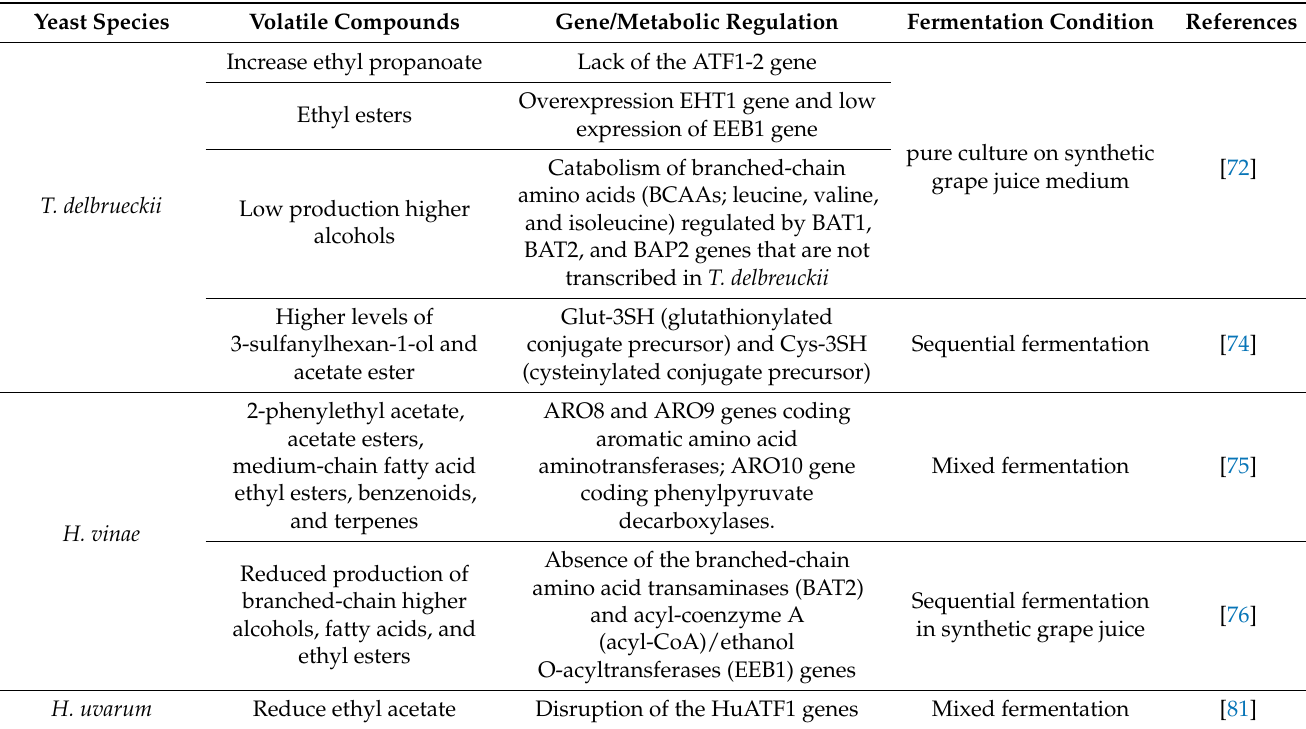
Table 3. Metabolic regulation of volatile compounds in different wine